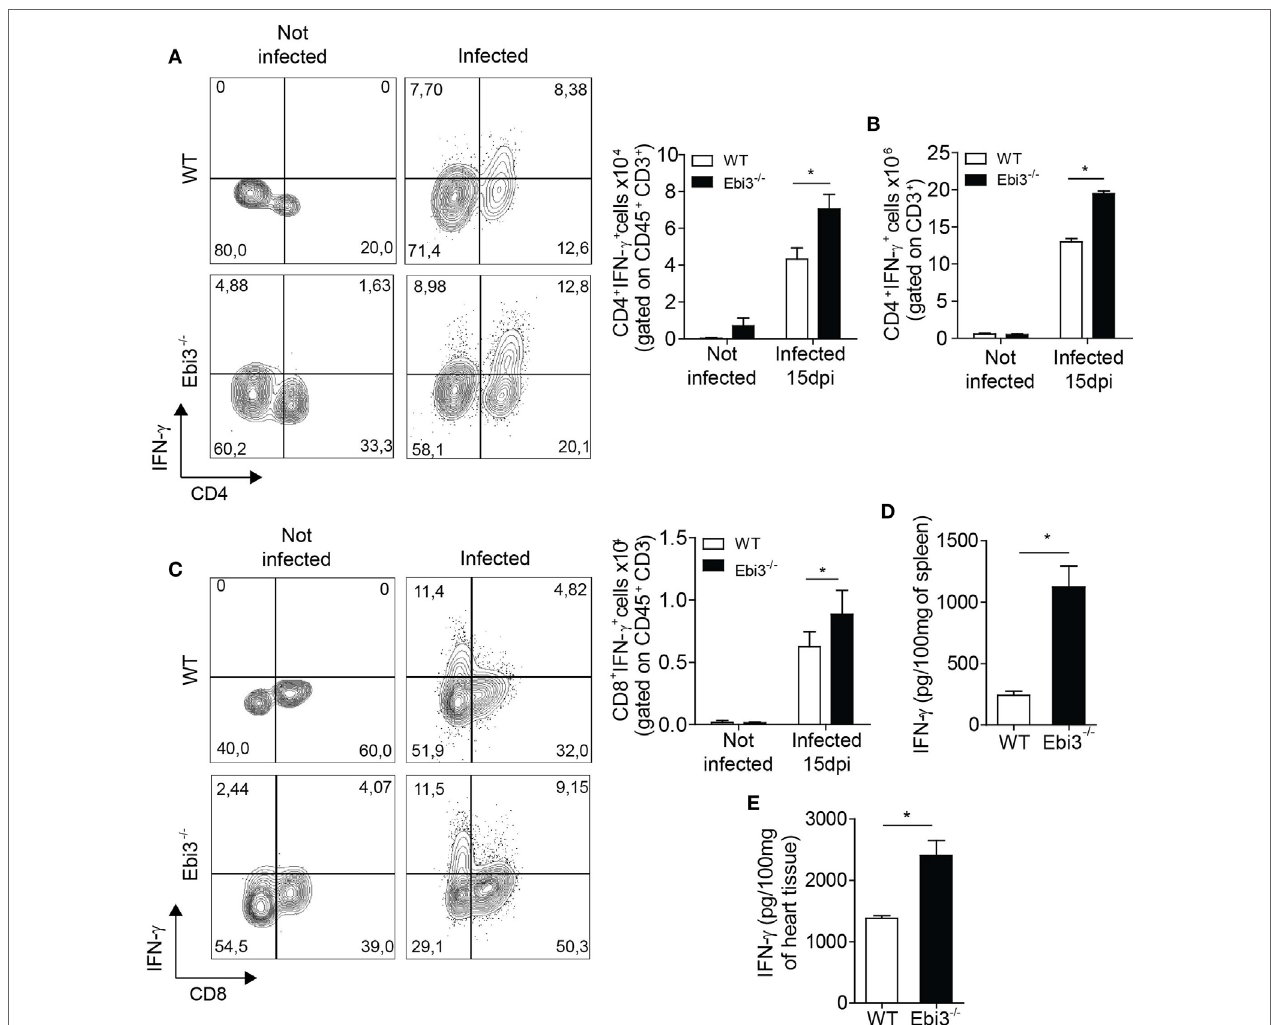
FigUre 6 | Inflammation in the spleen and heart of Ebi3-deficient mice is characterized by increased number of IFN- γ -producing T cells and higher secretion of IFN- γ . (a–c) Number of CD3 + CD4 + IFN- γ + or CD3 + CD8 + IFN- γ + infiltrating cells in the heart and spleen of wild-type (WT) and Ebi3-deficient mice. Cells from heart and spleen of WT and Ebi3 − / − naïve mice or infected with 10 3 Trypanosoma cruzi tripomastigotes after 15 d.p.i. were stimulated in vitro with PMA/Ionomycin for 6 h and stained with anti-CD3 and anti-CD4 or anti-CD8 antibodies followed by intracellular staining with anti-IFN- γ antibody. (D,e) Production of IFN- γ in the homogenate of spleen and heart tissue 15 d.p.i. was quantified by ELISA. Data shown are expressed as mean ± SEM *( P < 0.05) and are representative of three independent experiments ( n =